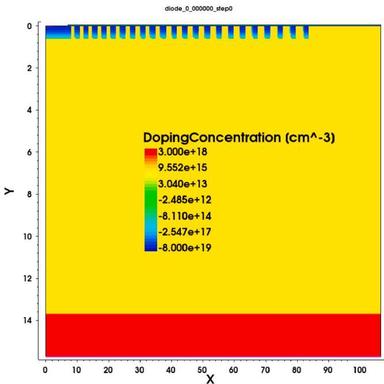
Cross-sectional view of the half-structure of the diode with its 22 guard rings.